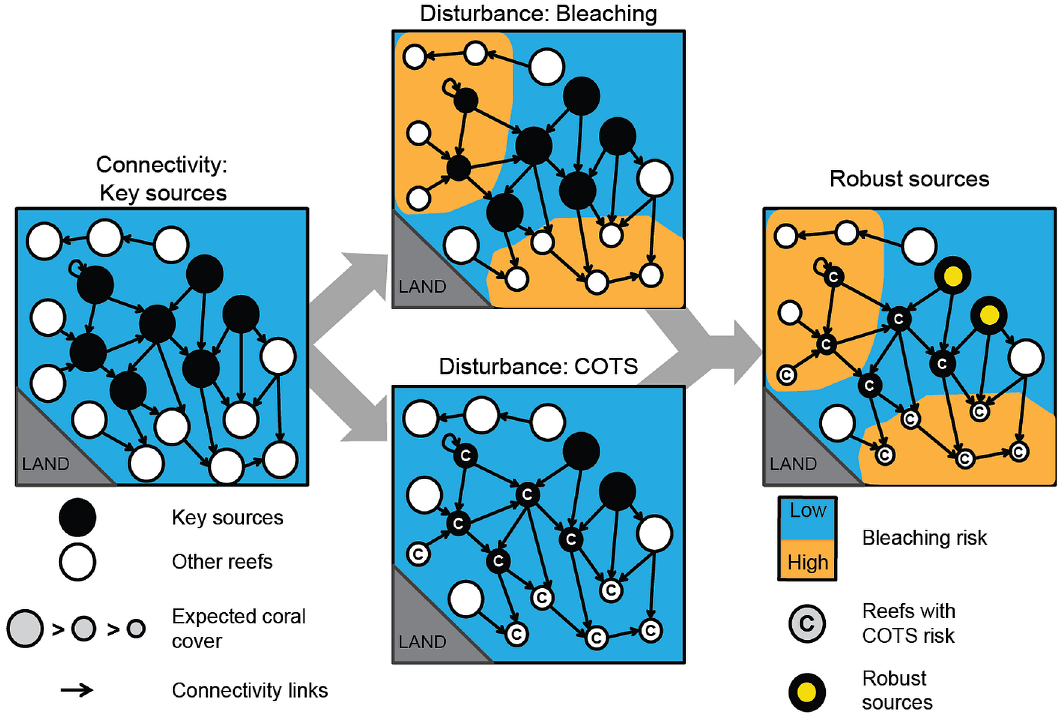
Fig 1. Conceptual diagram describing the process for identifying robust source reefs in a coral reef system. Ocean currents disperselarvae and create interpopulation connectivity links amongreefs, leadingto an emergence of source reefs with high potentialto support coral replenishment. For robust sources, high connectivity will be complementedby a reduced chance of being affected by disturbances, such as thermal stress–induced bleaching,and COTS outbreaks. COTS, crown- of-thorns